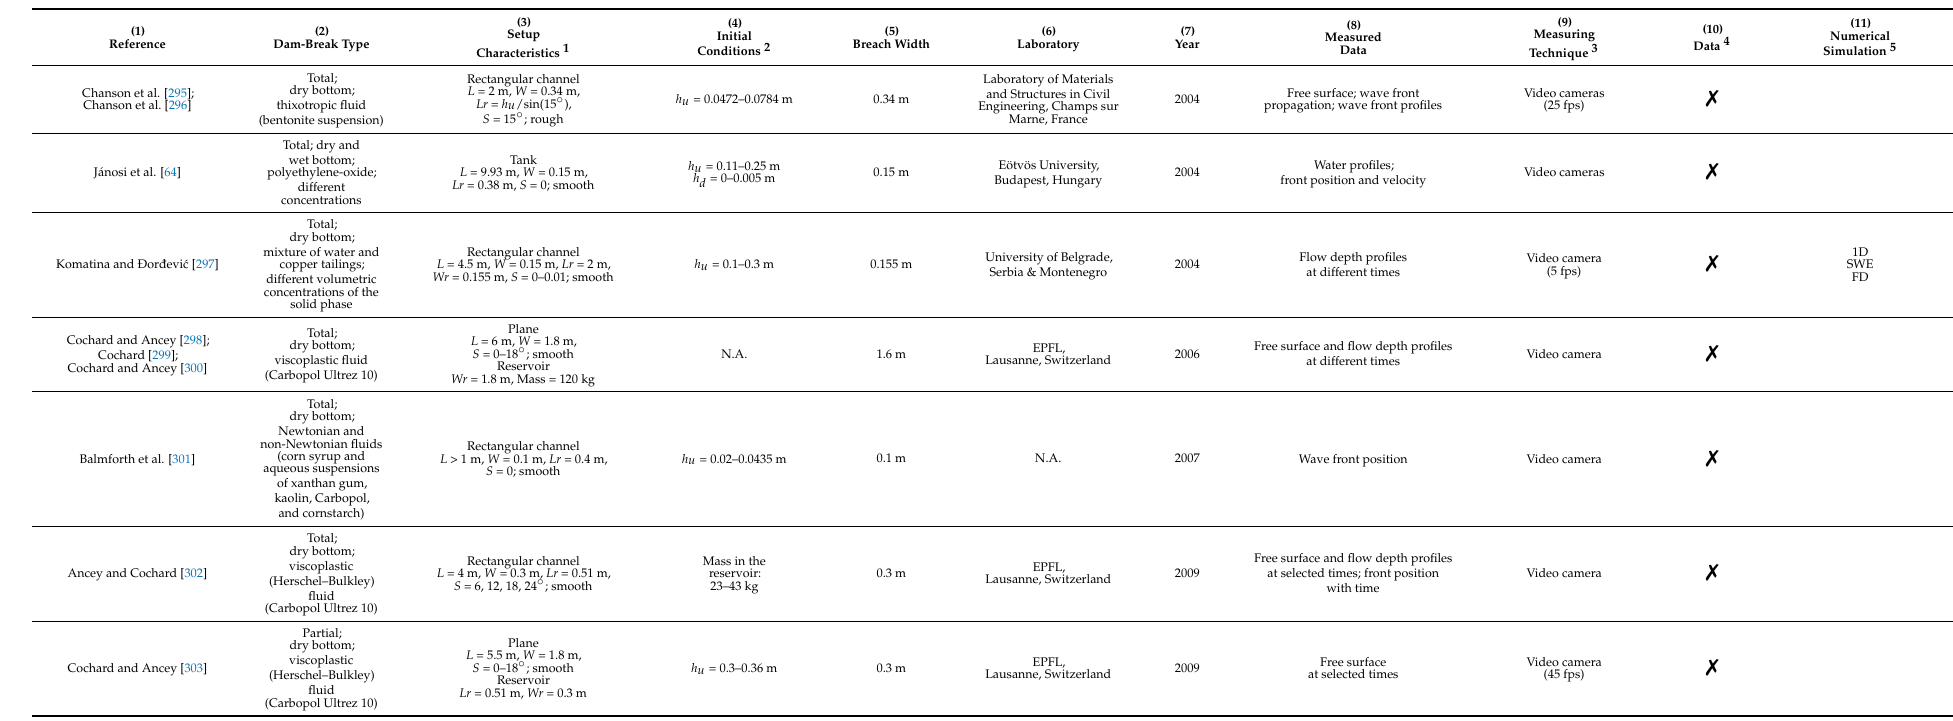
Table 7. Experimental investigations of dam-break waves of non-Newtonian fluids.